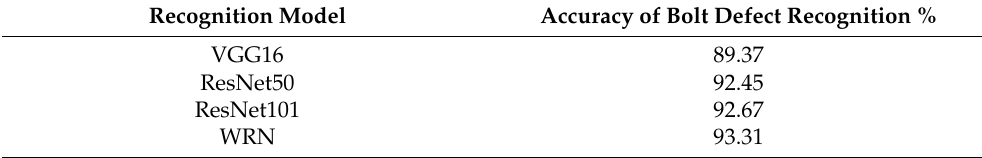
Table 2. Ablation test